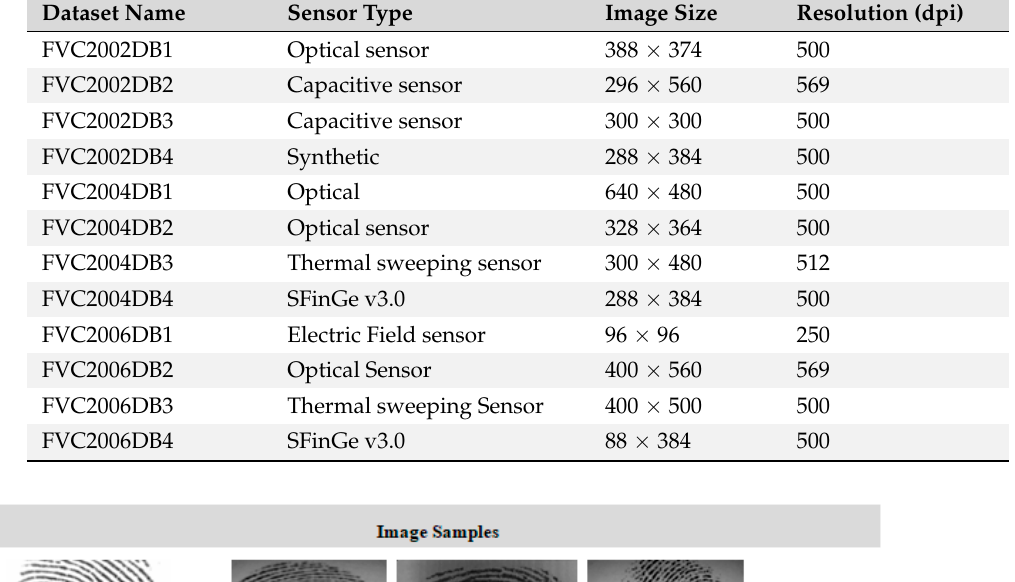
Table 2. Fingerprint database description.